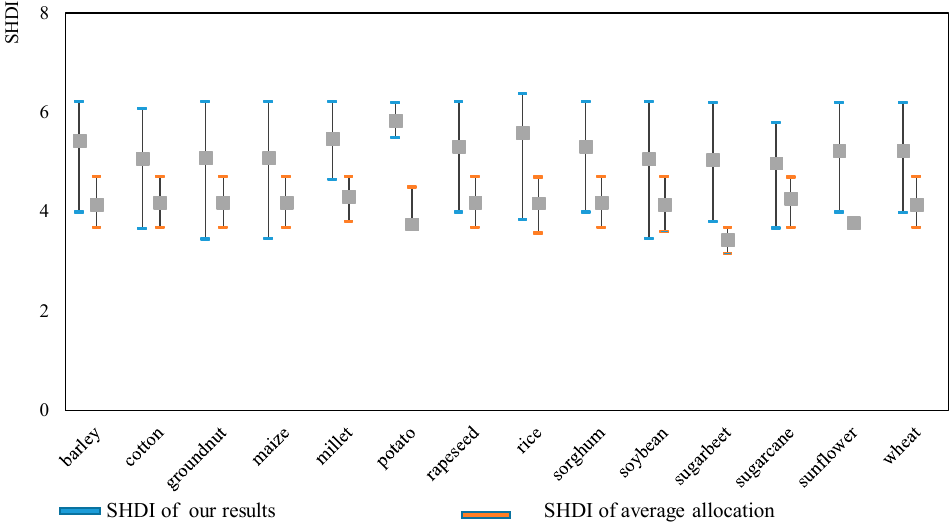
Figure 7. Comparison of the variation in SHDI between the results from our model and those from the average allocation model for each crop.